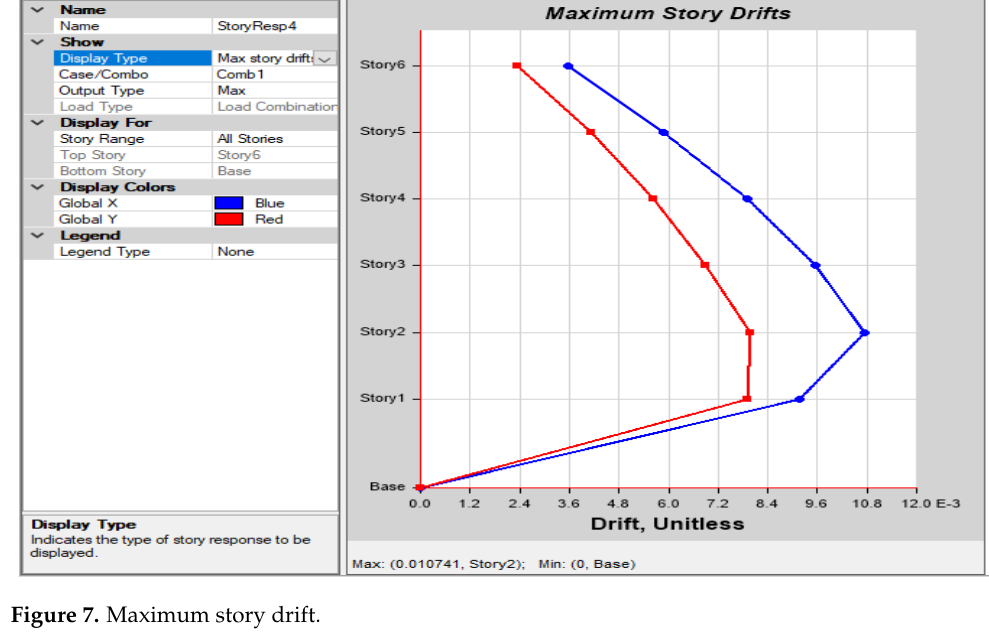
11 Figure 6. Maximum story displacement.